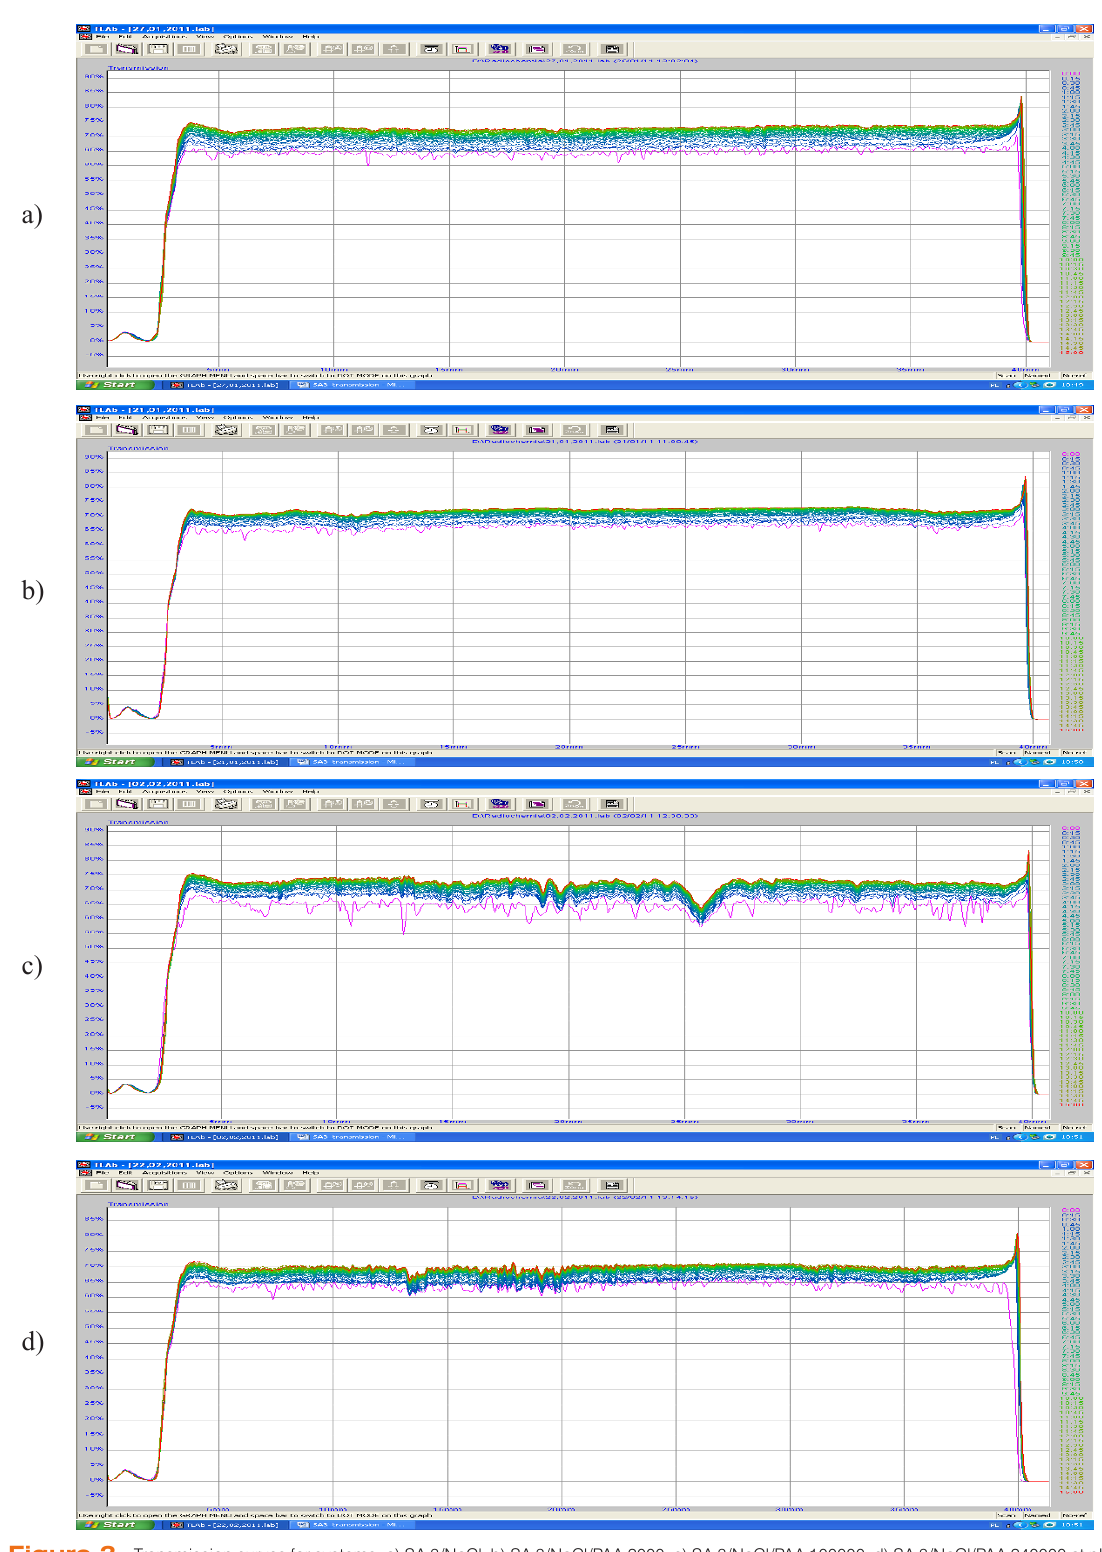
Figure 3. Transmission curves for systems: a) SA 3/NaCl, b) SA 3/NaCl/PAA 2000, c) SA 3/NaCl/PAA 100000, d) SA 3/NaCl/PAA 240000 at pH=9. The level of suspension in the measurement vial [mm] is along the x axis and the light intensity transmitted through the suspension [%] is along the y